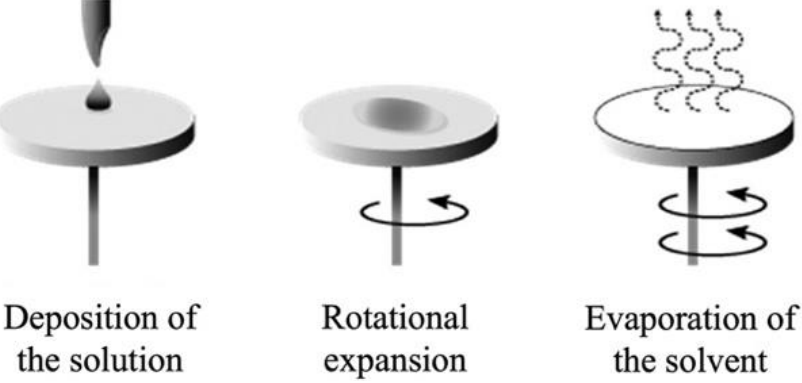
Figure 4. Schematic representation of spin coating process.